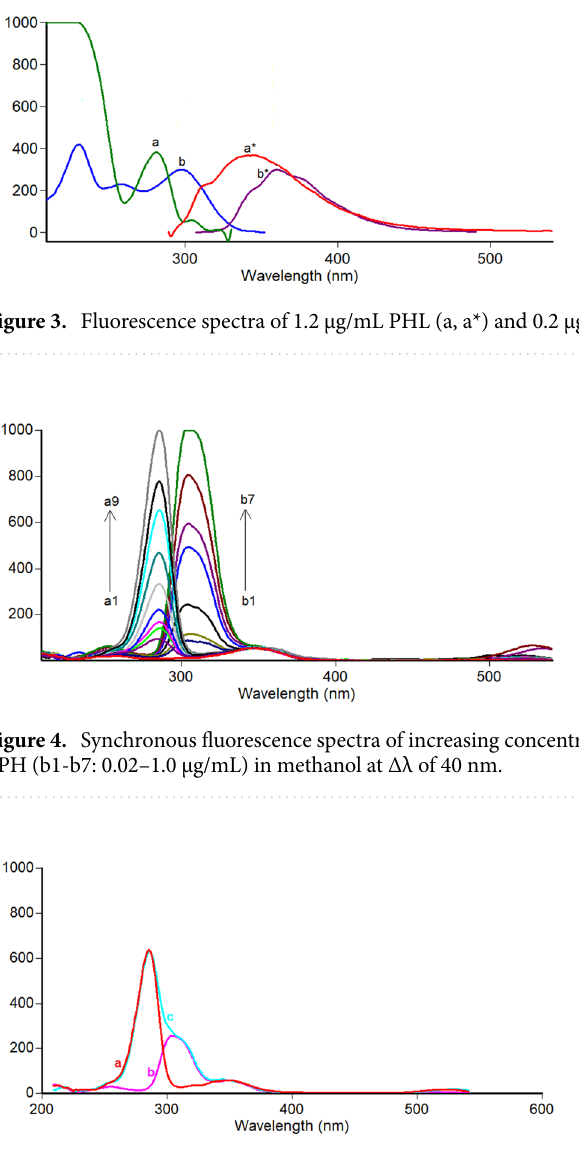
Figure 5. Synchronous fluorescence spectra of (a). PHL (4.0 μg/mL), (b). EPH (0.2 μg/mL), (c). synthetic mixture of PHL and EPH at Δλ = 40